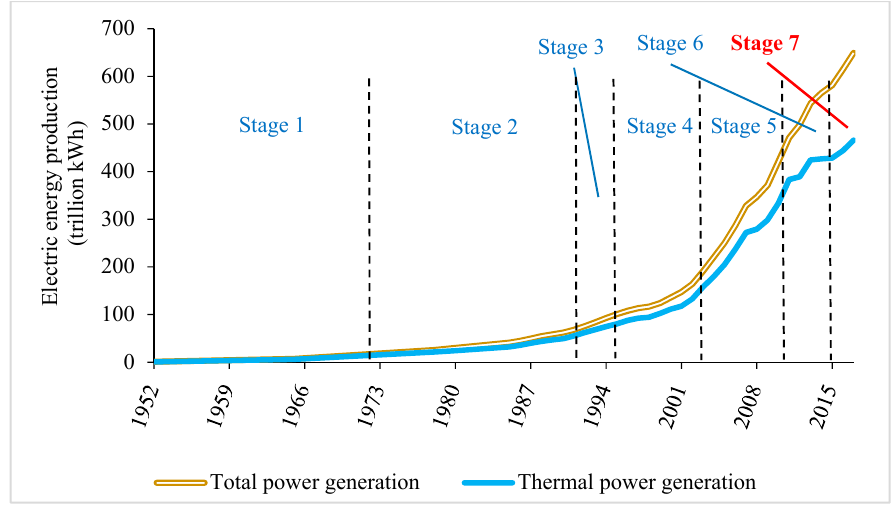
Figure 3. Statistics on China’s electricity production at different stages from 1952 to 2017 (data source: National Bureau of Statistics of China).